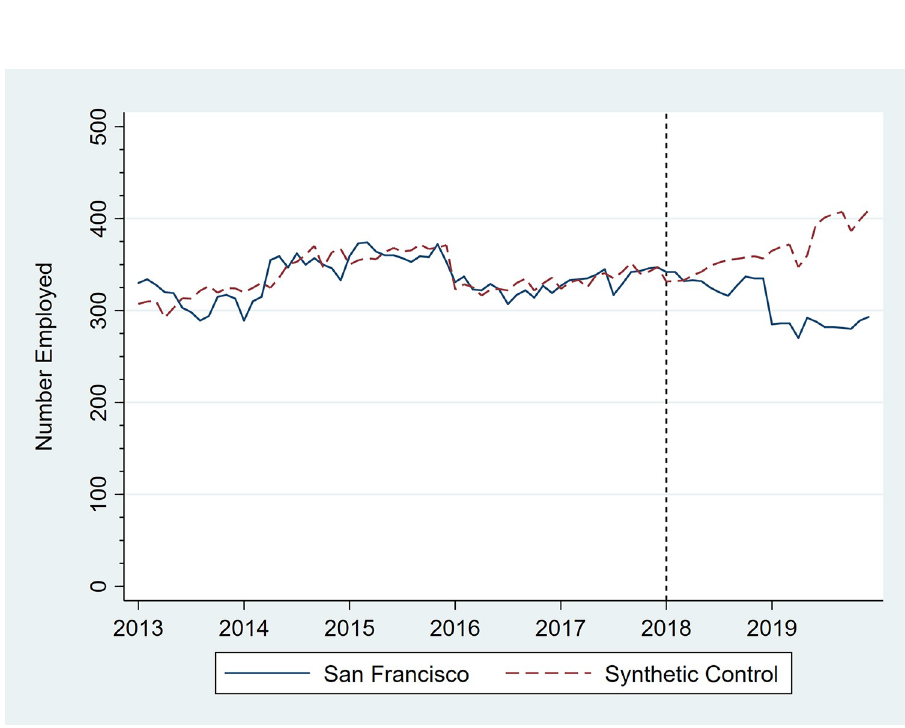
Fig 4. Number of persons employed in convenience stores, San Francisco, CA, and its synthetic control, monthly, January 2013 through December 2019.